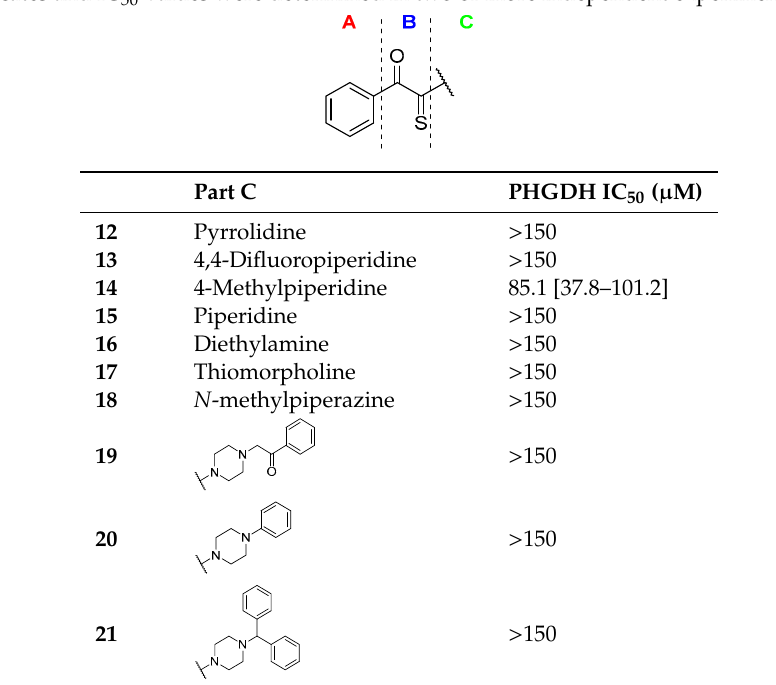
Table 3. Results of PHGDH inhibition for compounds 12 – 21 . All experiments were performed with at least triplicates and IC 50 values were determined in two or more independent experiments.